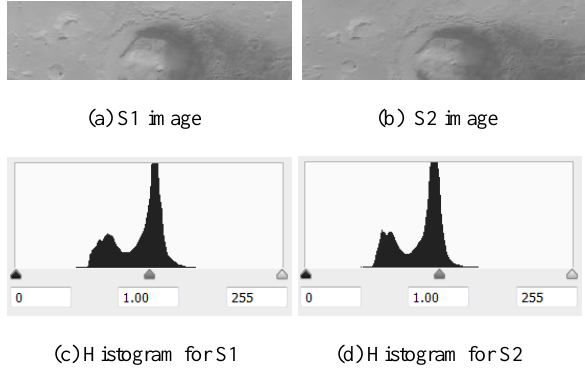
Figure 1. The histogram of HRSC Level-2 images.